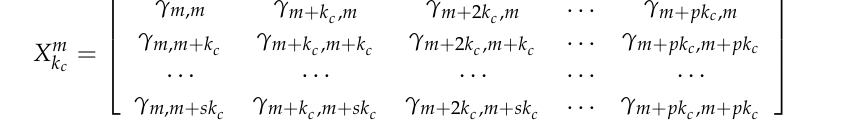
(cid:4675) , (cid:3038) (cid:3278)